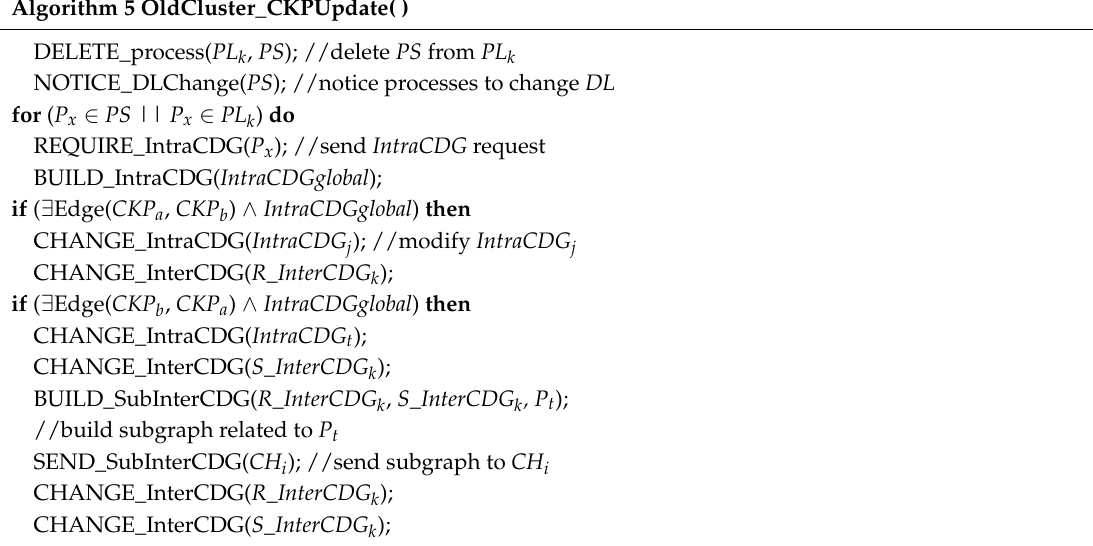
Algorithm 5 OldCluster_CKPUpdate(